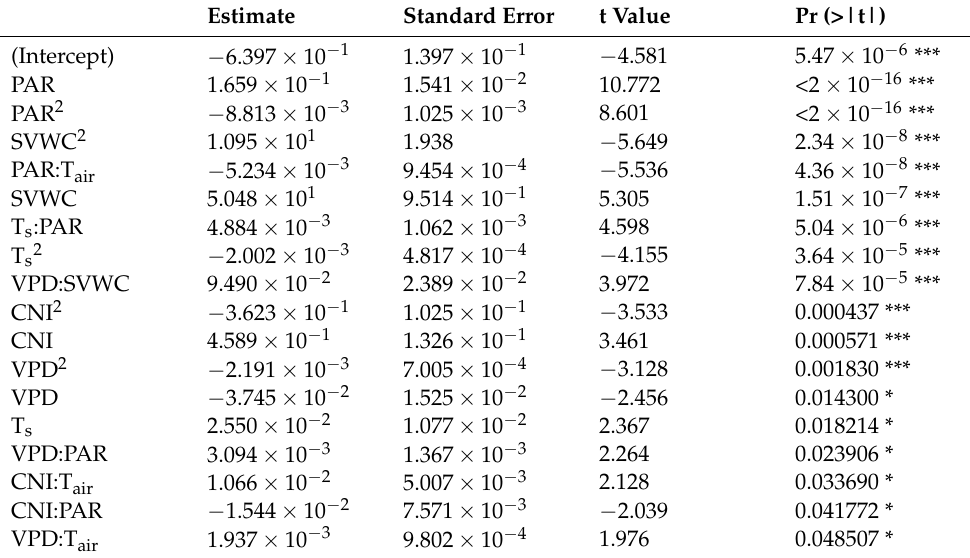
Table A3. Results of the stepwise multi-linear regression model on the significant environmental variables that influenced the normalized gross primary productivity (GPP norm ) at the wet spruce forest site in Bílý K˘rí˘z (CZ-BK1). CNI: clearness index; PAR: photosynthetic available radiation; T air : air temperature; T s : soil temperature; SVWC: the soil volumetric water content; and VPD: vapour pressure deficit. Estimate